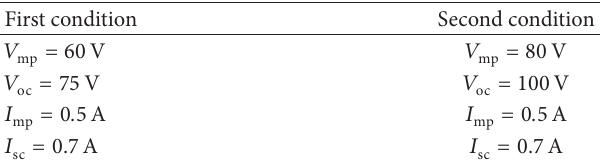
Table 2: Conditions of the PV